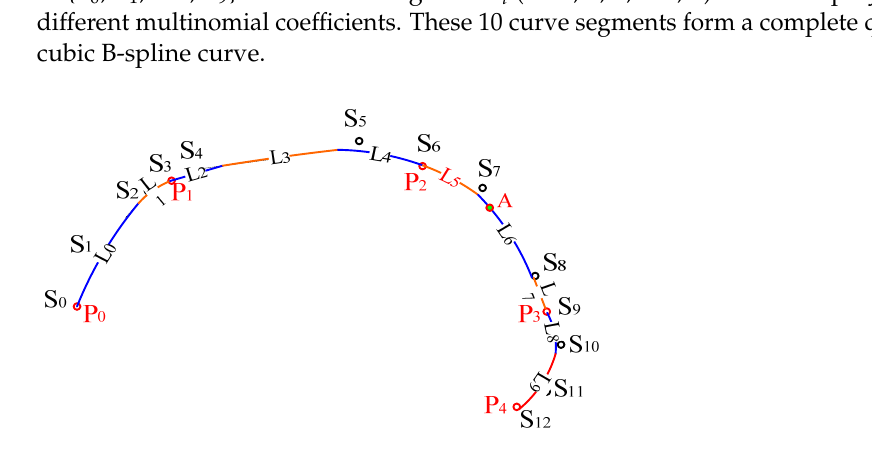
Figure 10. The mapping result for the multiple repeats of the curve.